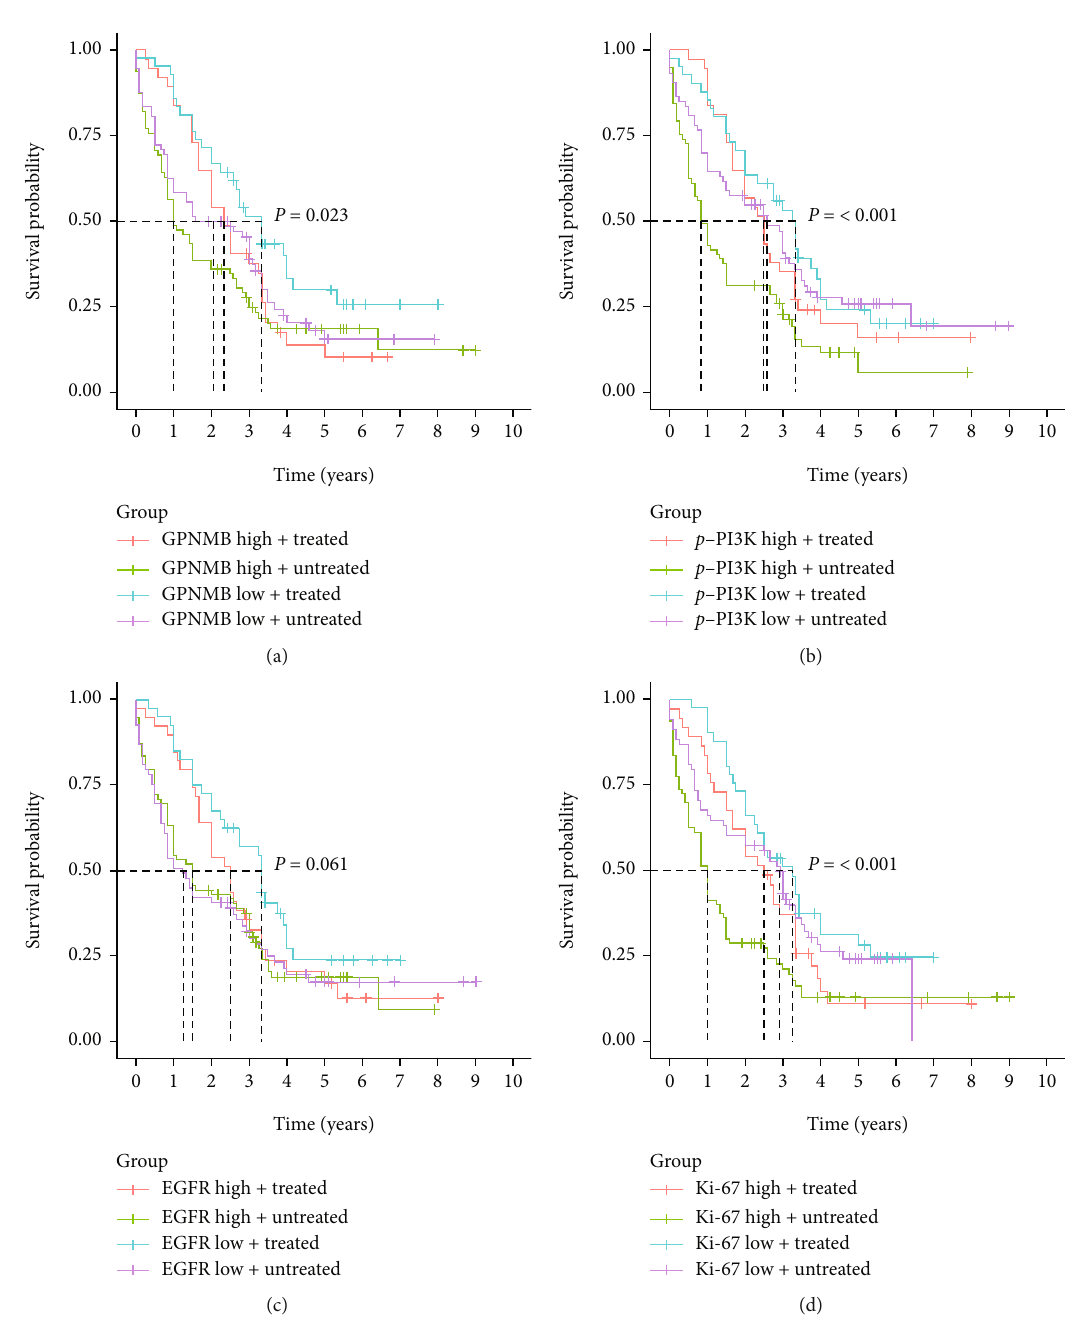
Figure 7: E ff ects of GPNMB, EGFR, p-PI3K, and Ki-67 combined with adjuvant therapy on prognosis. (a) The prognostic di ff erence of GPNMB expression with or without combined treatment; (b) the prognostic di ff erence of p-PI3K expression with or without combined treatment; (c) the prognostic di ff erence of EGFR expression with or without combined treatment; (d) the prognostic di ff erence of Ki-67 expression with or without combined treatment. Log-rank test was used to compare the di ff erence of multiple